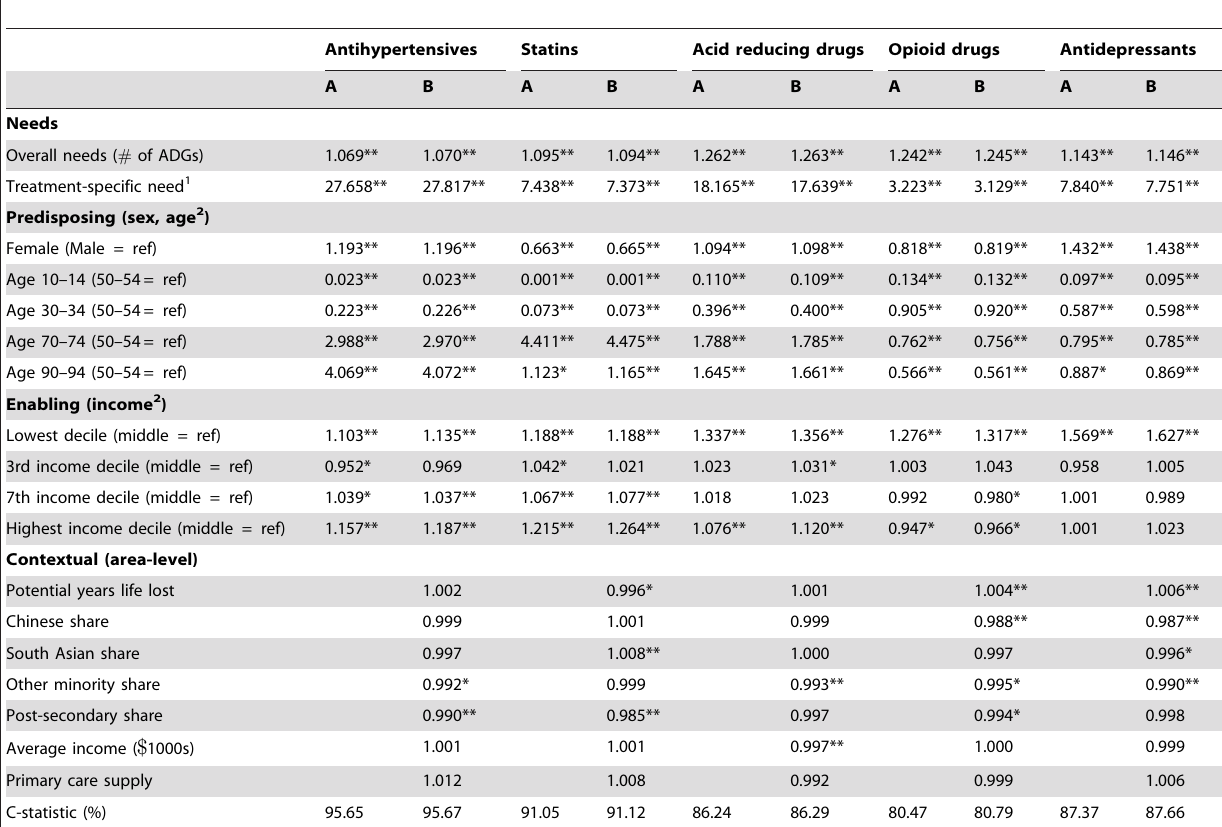
Table 2. Adjusted odds ratios for the likelihood of purchasing one or more prescription from specific therapeutic categories in 2006, non-rural local health areas of British